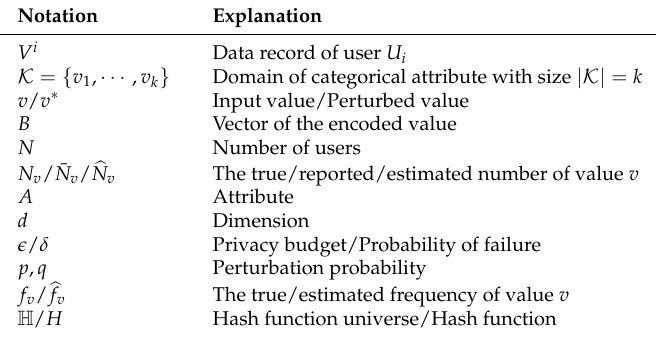
Table 1. The commonly used